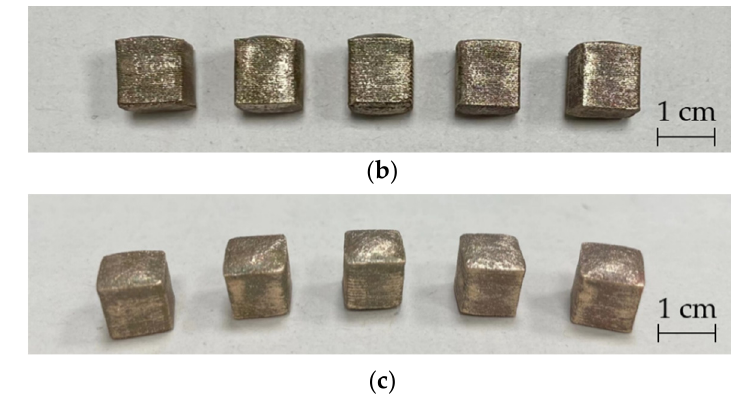
Figure 5. Sintered cubes according to five sintering directions before and after sintering: ( a ) cubes according to five sintering directions were embedded in sand; ( b , c ): cubes after sintering (from left to right: sintering on xy surface, on xz surface, on yz surface, on an edge, and on a point). The volume of the green part cube was 1 cm 3 (1000 mm 3 ), and the weight was generally 4 g (±5%). In Table 4 the weight, shrinkage, and density increase were obtained for the dimensional shrinkage of the x -, y -, and z -axes. The shrinkage of the x - and y -axes was between 20% and 21% and the shrinkage of the z -axis was between 11% and 14%. After sintering the mass loss of the specimen was about 15%, which also confirmed the mass fraction of bronze is 85%. Additionally, the density increased from 3.7 g/cm 3 to about 6.6